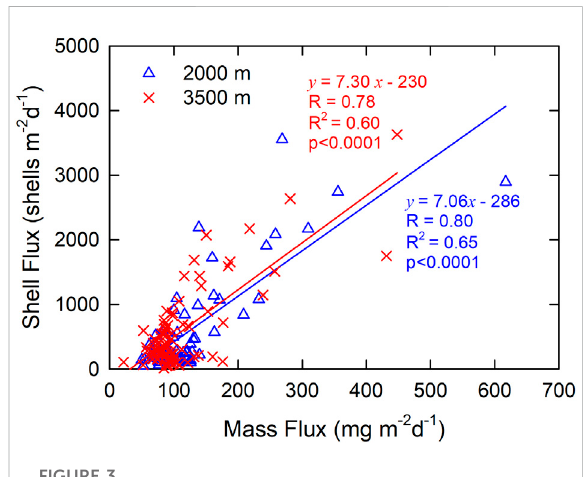
FIGURE 3 Shell vs. mass fl uxes at 2,000 m (blue triangle) and 3,500 m (red triangle) between 2016 and 2019 at SEATS station. The lines and equations in blue and red show the linear regression results of data at 2,000 m and 3,500 m,